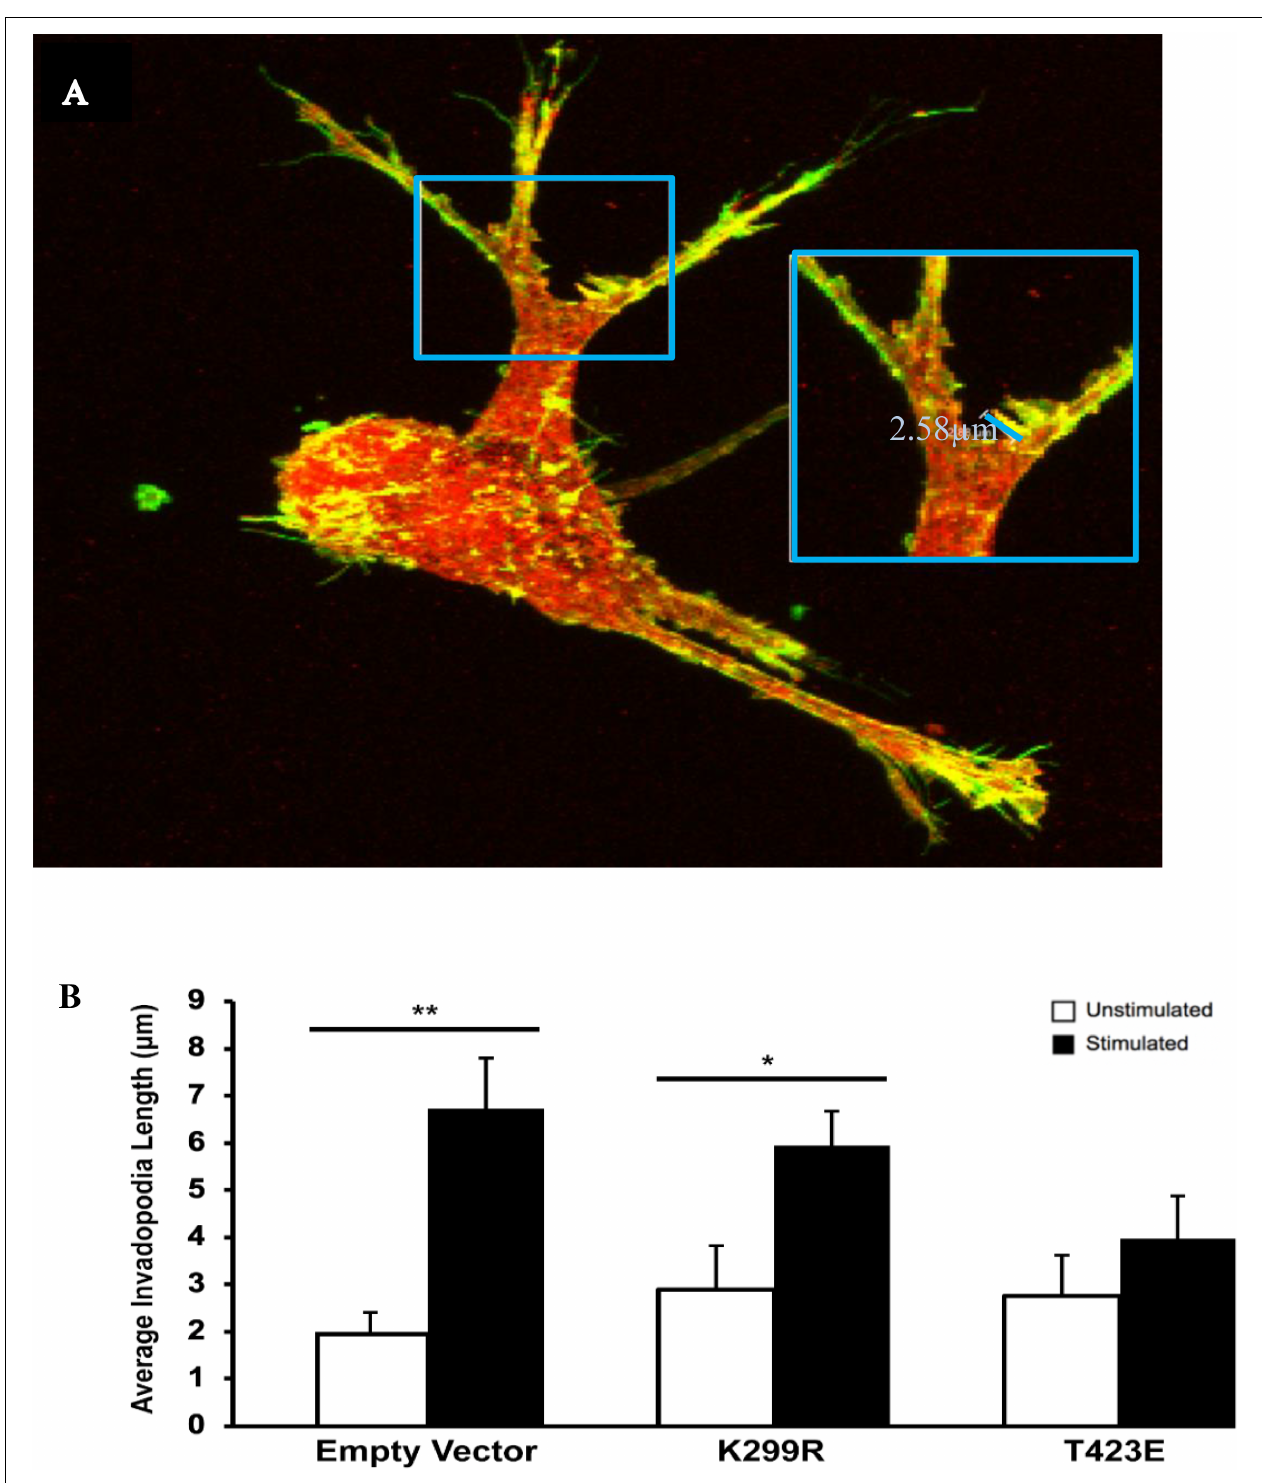
FIGURE 4 | (A) The length of invadopodia can be measured based on actin and cortactin colocalization represented as yellow, images collected by confocal microscopy. (B) Invadopodia fail to elongate in response to transient mechanical stimulation with an overactive PAK1. When PAK1 is made less active in HT1080 cells (K299R), invadopodia continue to elongate in response to transient mechanical stimulation. However, when PAK1 is constitutively active (T423E), invadopodia do not elongate in response to stimulation. ∗ P < 0.05, ∗∗ P < 0.01 by Student’s t -test, data from at least three independent experiments. Error bars represent the SEM.